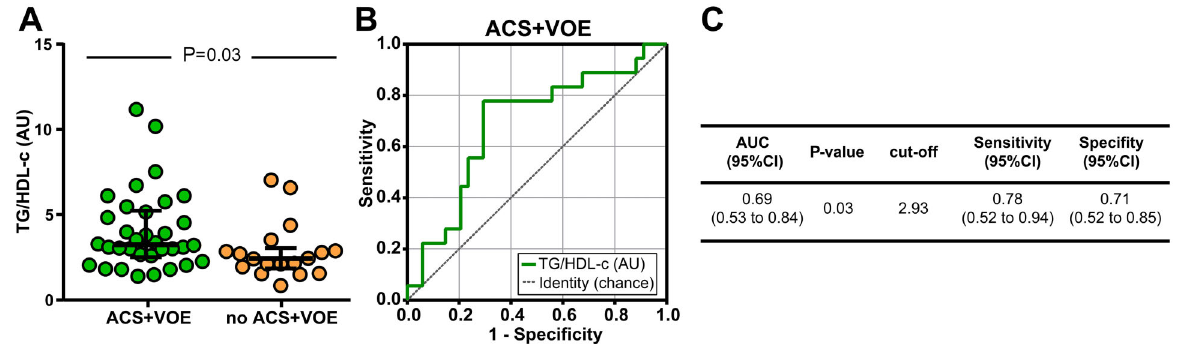
Figure 3. Using triglycerides (TG):high-density lipoprotein cholesterol (HDL-c) ratio values in sickle cell anemia (SCA) patients to identify individuals with acute chest syndrome (ACS) and/or vaso-occlusive episodes (VOE). A , TG/HDL-c values were compared between the ACS + VOE group and controls using the Mann-Whitney U test. Lines represent median values and interquartile ranges. B , Receiver operator characteristics (ROC) curve analysis was employed to test the accuracy of TG/HDL-c values to discriminate between individuals with ACS + VOE history and controls. C , Detailed information obtained from the ROC curve, such as area under curves (AUC), P value of the ROC curves, cut-off value, and sensitivity and speci fi city with the 95% con fi dence interval (CI).